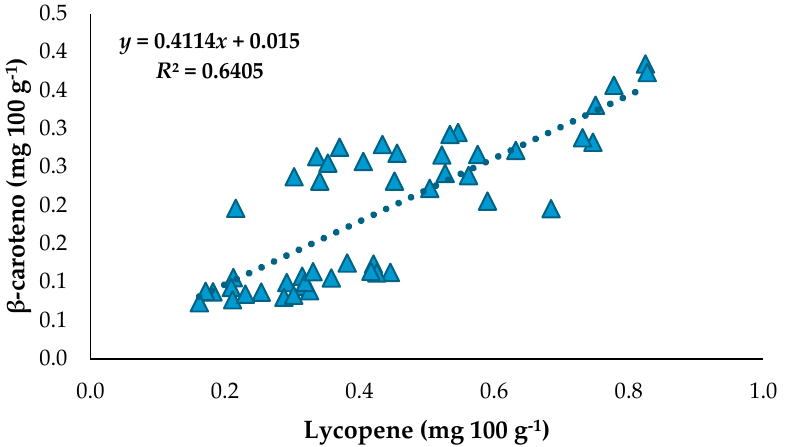
Figure 3. Quadratic correlation between β -carotene and lycopene content. Four repetitions per treatment were used for the correlation.